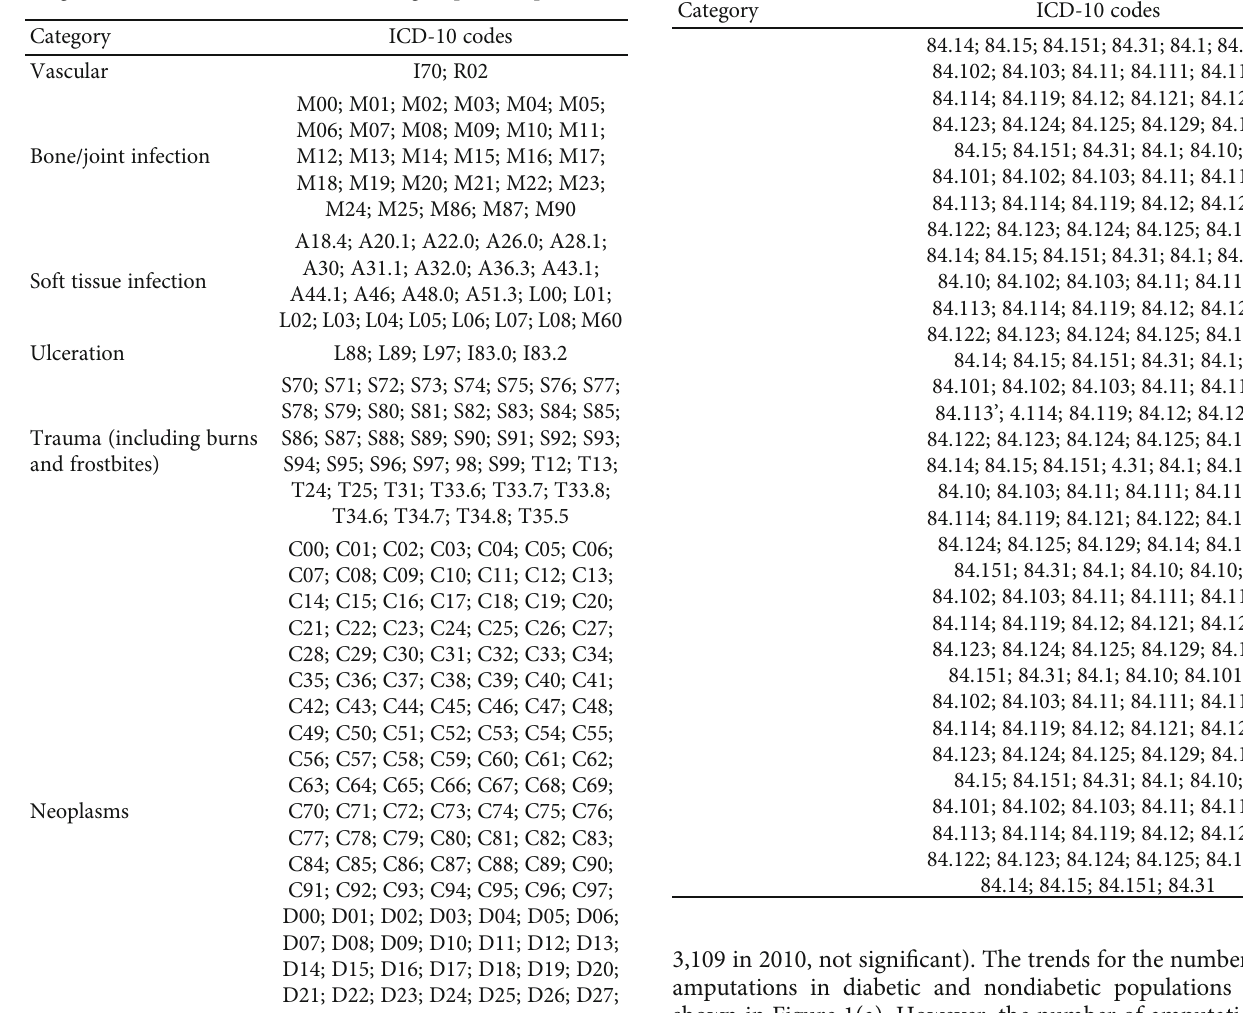
Table 1: ICD-10 codes used for de fi ning the diagnosis at discharge categories and ICD-9 codes used for de fi ning amputation